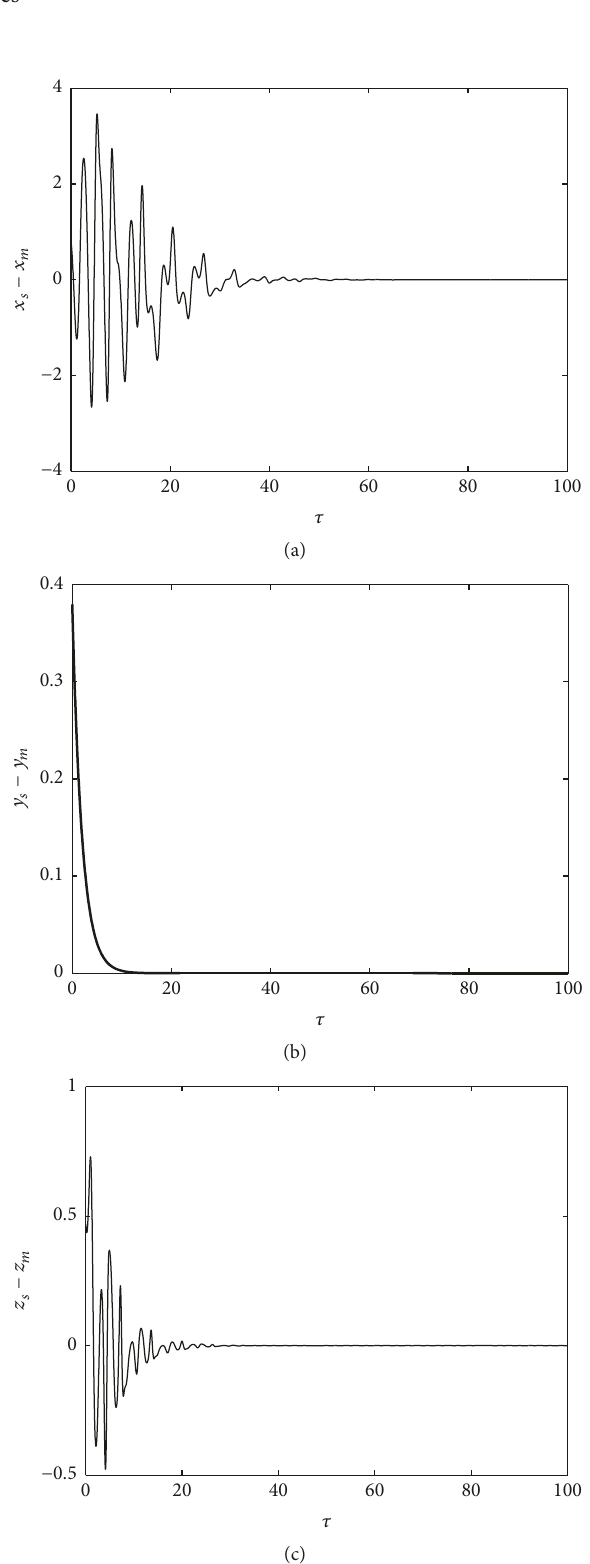
Figure 12: Error dynamics showing transition to synchronized states of the system and its observer. (a) 𝑒 𝑥 = 𝑥 𝑠 − 𝑥 𝑚 , (b) 𝑒 𝑦 = 𝑦 𝑠 − 𝑦 𝑚 , and (c) 𝑒 𝑧 = 𝑧 𝑠 − 𝑧 𝑚 . The initial conditions are chosen randomly as 𝑥 𝑚 (0) = 0.01 , 𝑦 𝑚 (0) = 0.02 , and 𝑧 𝑚 (0) = 0.03 and 𝑥 𝑠 (0) = 0.8 , 𝑦 𝑠 (0) = 0.4 , and 𝑧 𝑠 (0) = 0.5 , respectively, for the drive and response systems. The master system parameters are 𝑎 = 6.8 , 𝑏 = 4 , and 𝑐 = 1 to ensure the chaotic